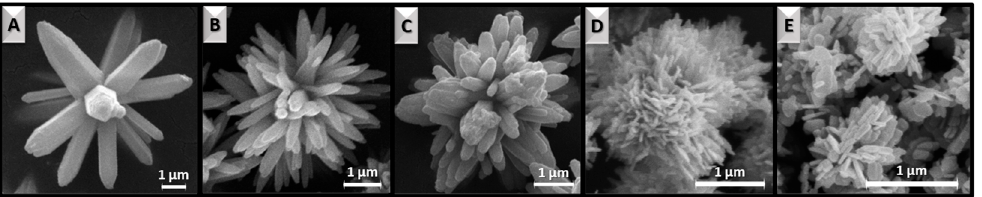
Figure 3. SEM images of ZnO x flower-like superstructures: ZnO 110 ( A ), ZnO 120 ( B ), ZnO 160 ( C ), ZnO 180 ( D ), and ZnO 200 ( E ), where x subscripts indicate the exact temperature (°C) of hydrothermal synthe- sis.